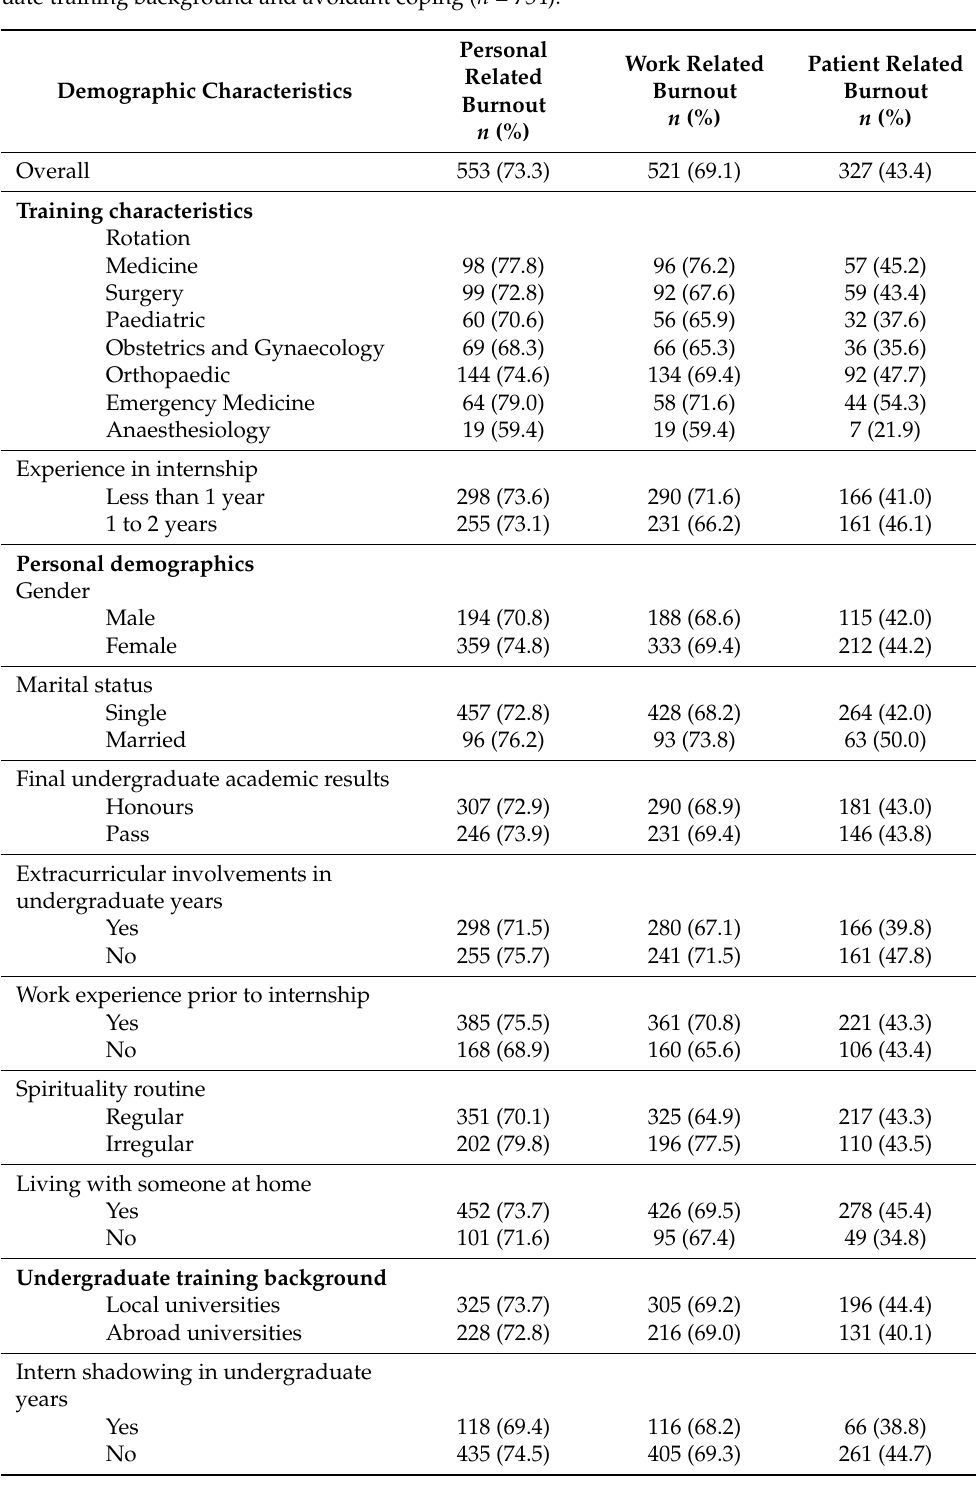
Table 2. Burnout prevalence for overall, training characteristics, personal demographics, undergrad- uate training background and avoidant coping ( n =